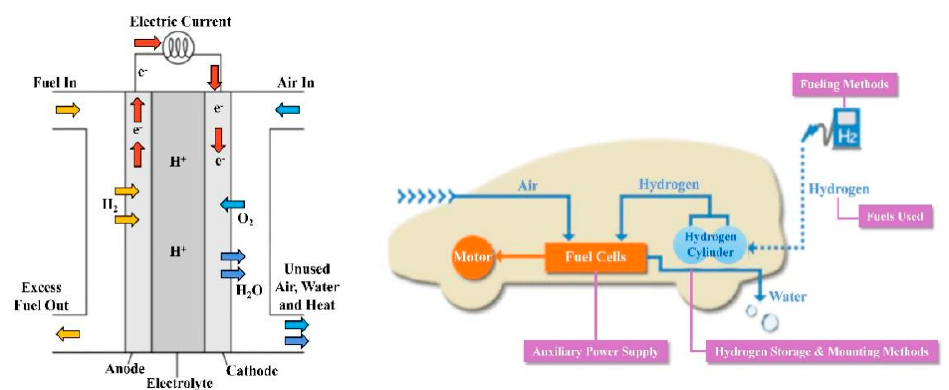
Figure 1. Schematic diagram of electrochemical process and application of a PEMFC